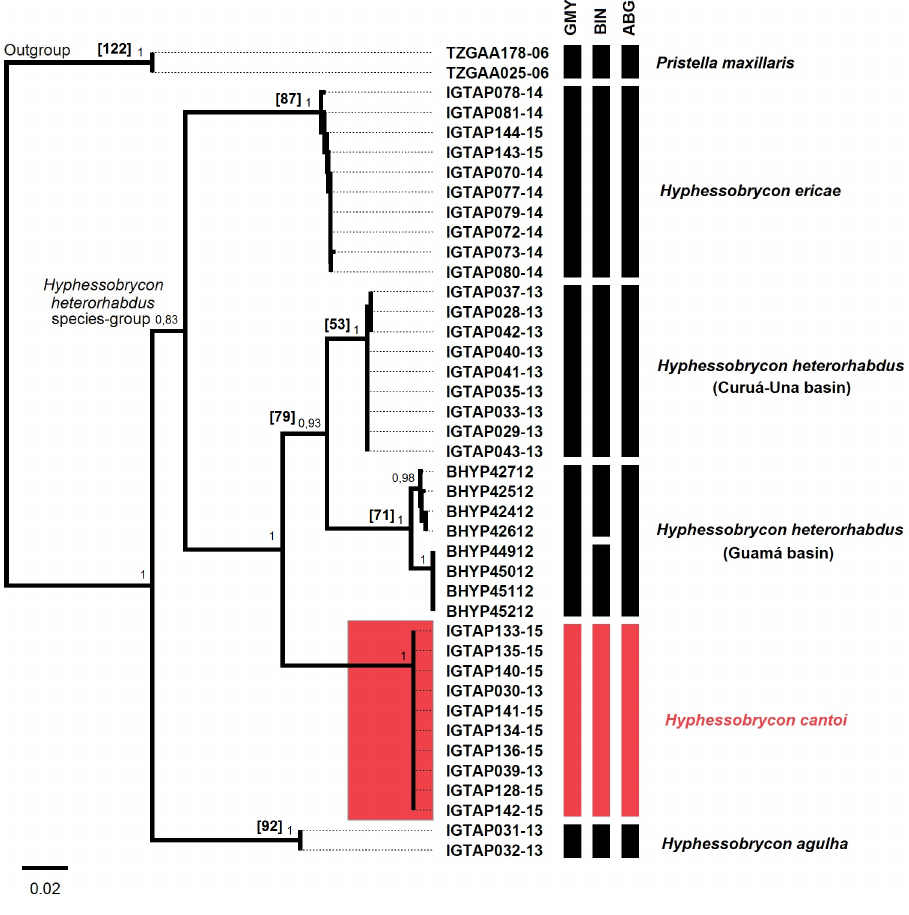
FIGURE 4 | Neighbor-joining tree of Hyphessobrycon cantoi and others lineages of H. heterorhabdus species- group. Red color indicating the new species. Species were delimited through GMYC, BIN and ABGD analysis. Values in brackets expressed the number variable sites that separate H. cantoi and values in branches indicate bootstrap